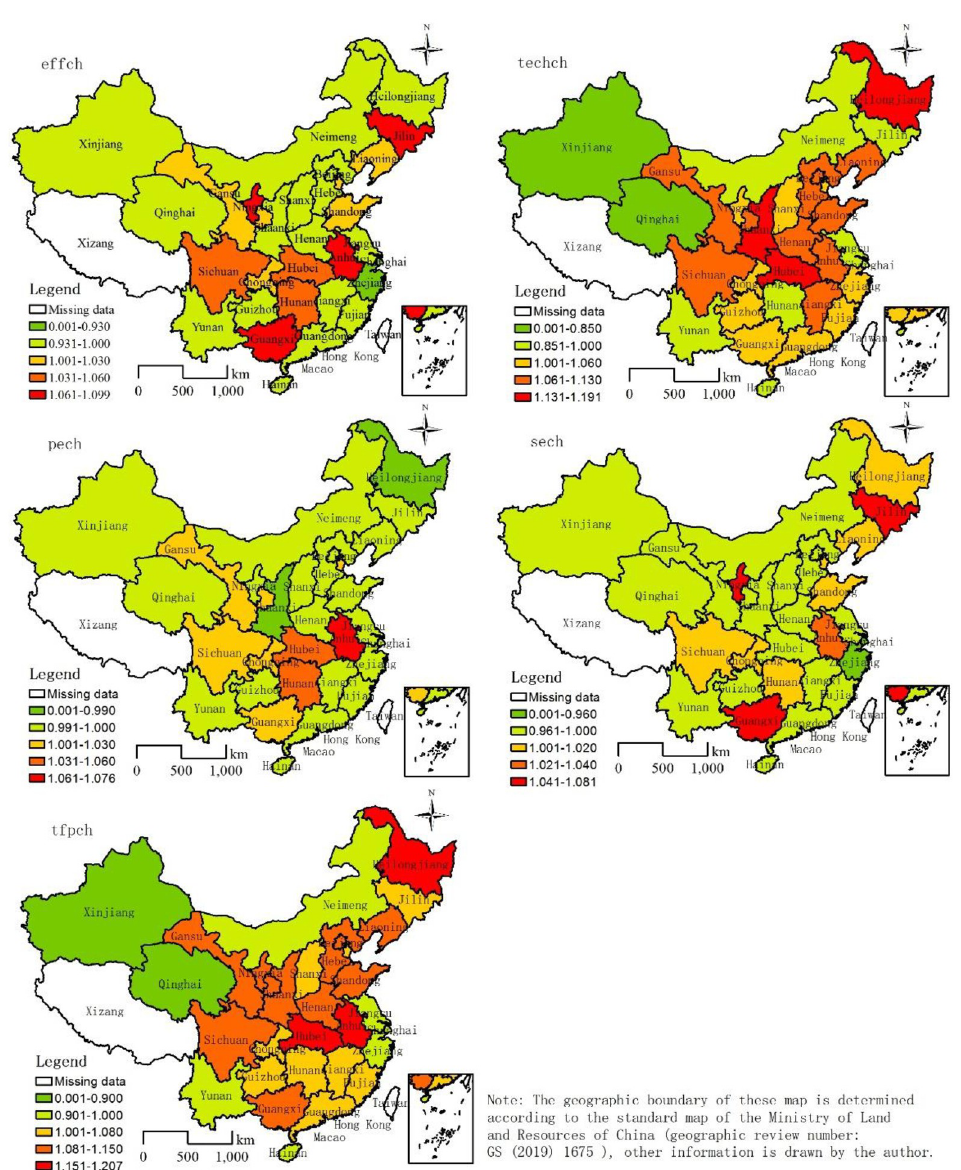
Fig 6. Spatial distribution of annual average of total factor productivity and its decomposition index for China’s high-tech industry from 2006 to 2016.